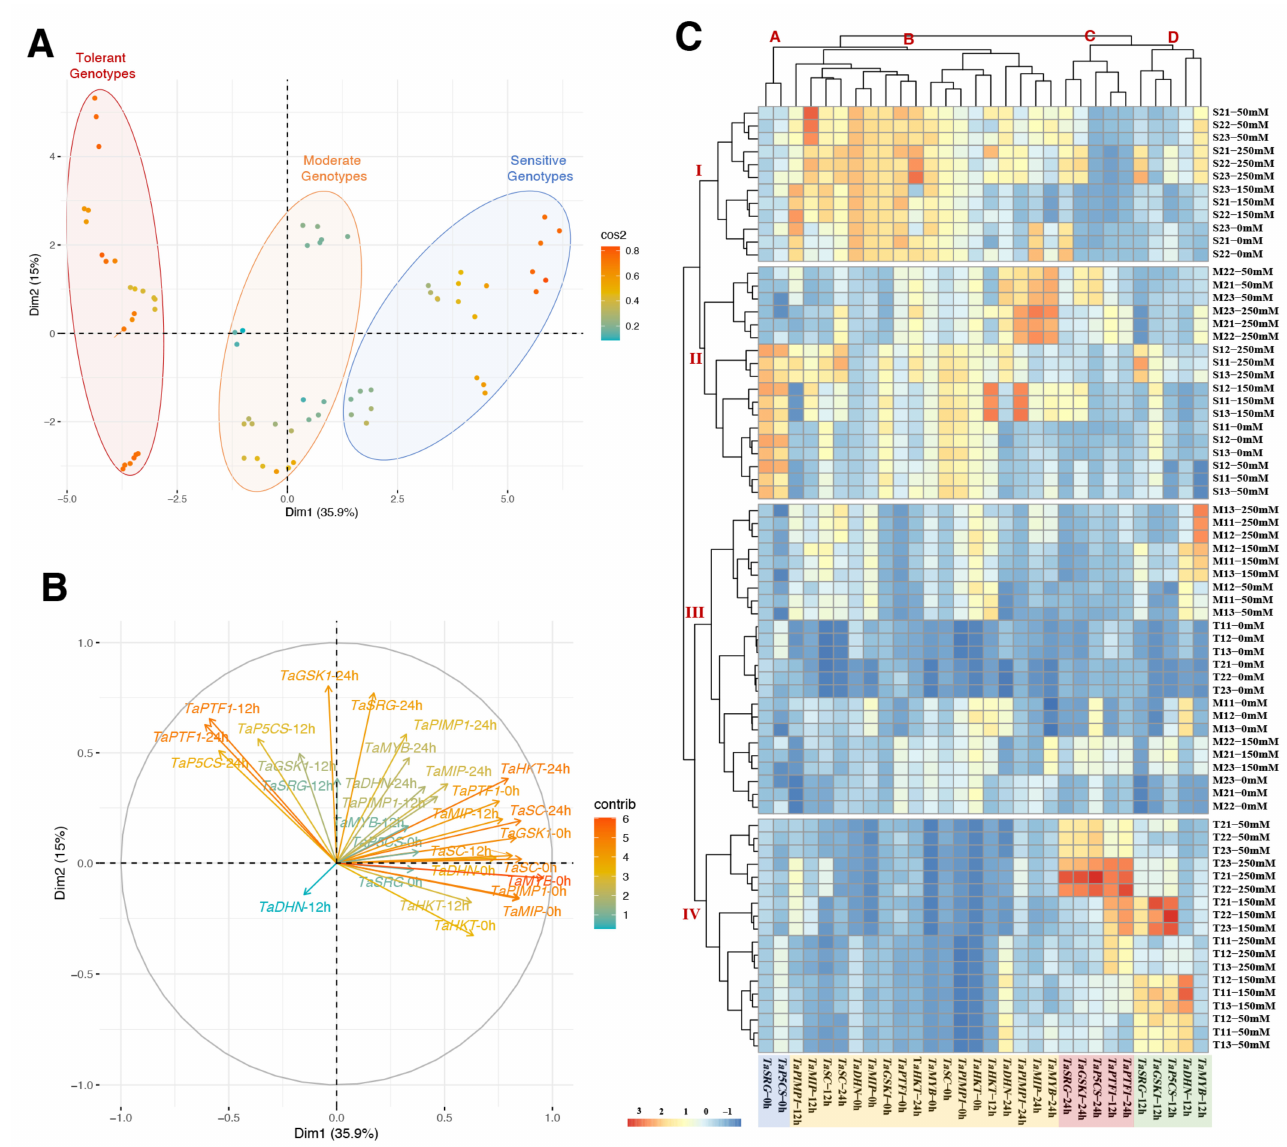
Figure 7. Principle component and hierarchical clustering analyses of genotypes and genes under salt stress and time course. ( A ) Principal component analysis (PCA) of the spatialization of two salt- sensitive, two moderate, and two tolerant genotypes (Colors blue: salt-sensitive, orange: moderate, and red: salt-tolerant genotypes), ( B ) PCA of the studied traits, ( C ) hierarchical clustering analysis (HCA) of measured gene expression level in salt-sensitive (S1, S2), moderate (M1, M2), and salt- tolerant (T1, T2) genotypes under 0, 12, and 24 h of 0, 50, 150, and 250 mM NaCl treatments. Clusters represent genotypes (I to IV), and genes (A to